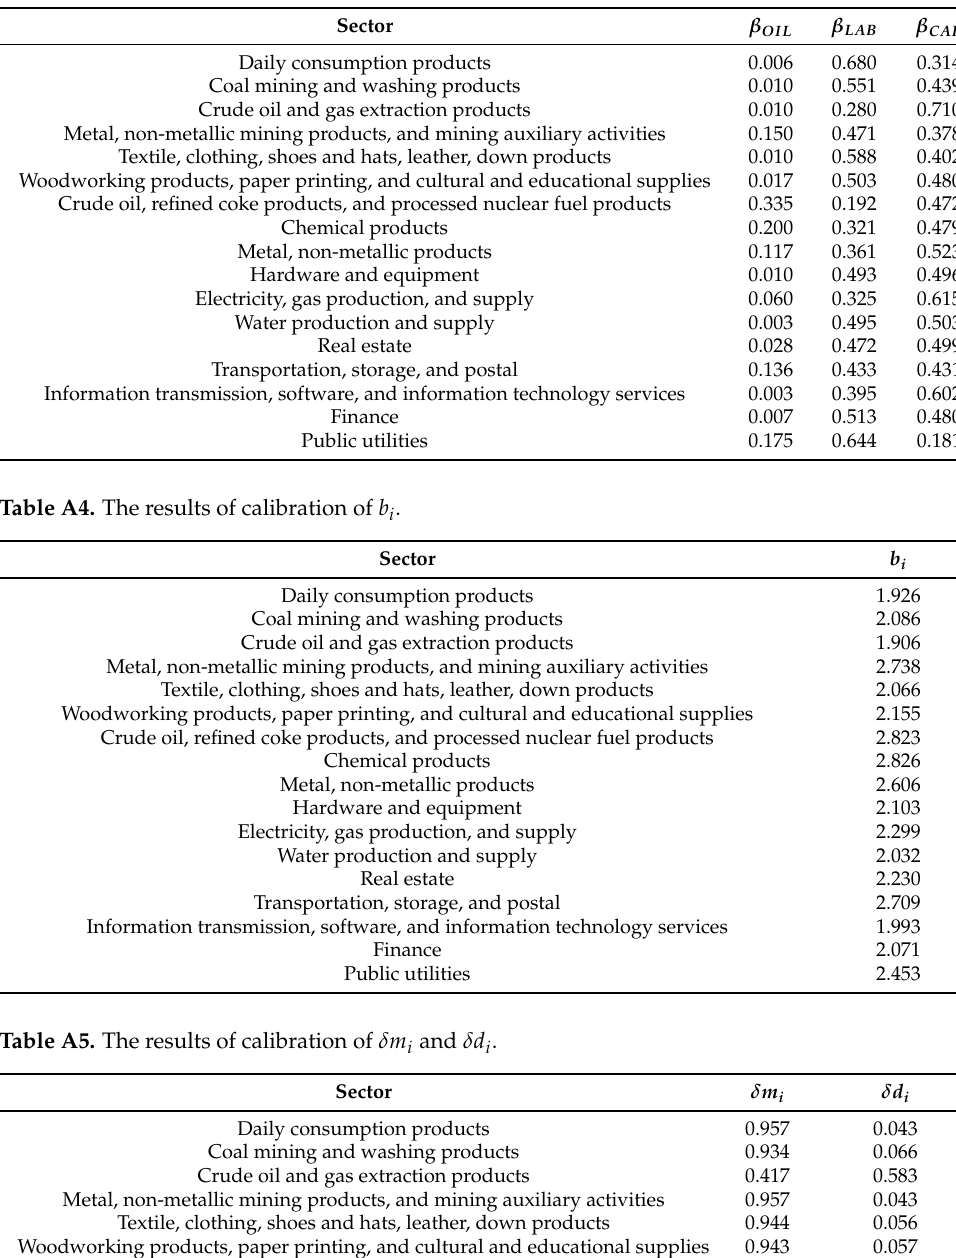
Table A3. The results of calibration of β h , j .